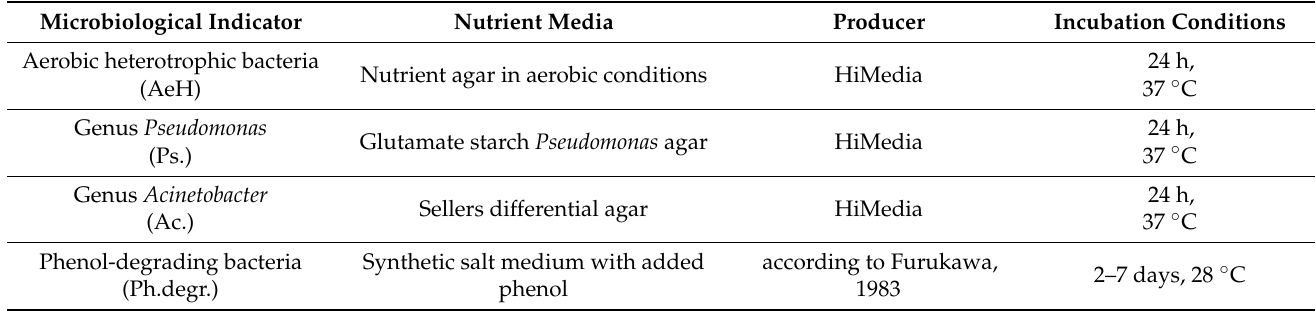
Table 1. Studied groups of microorganisms, nutrient media, and cultivation